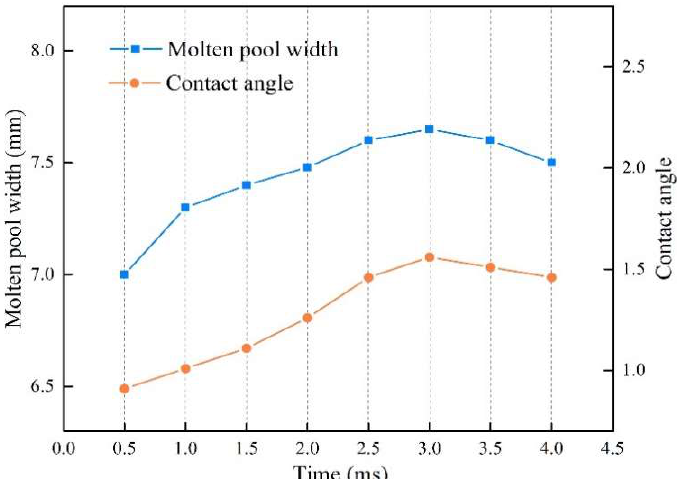
Figure 13. The change process of the weld pool size at a welding current of 80 A.